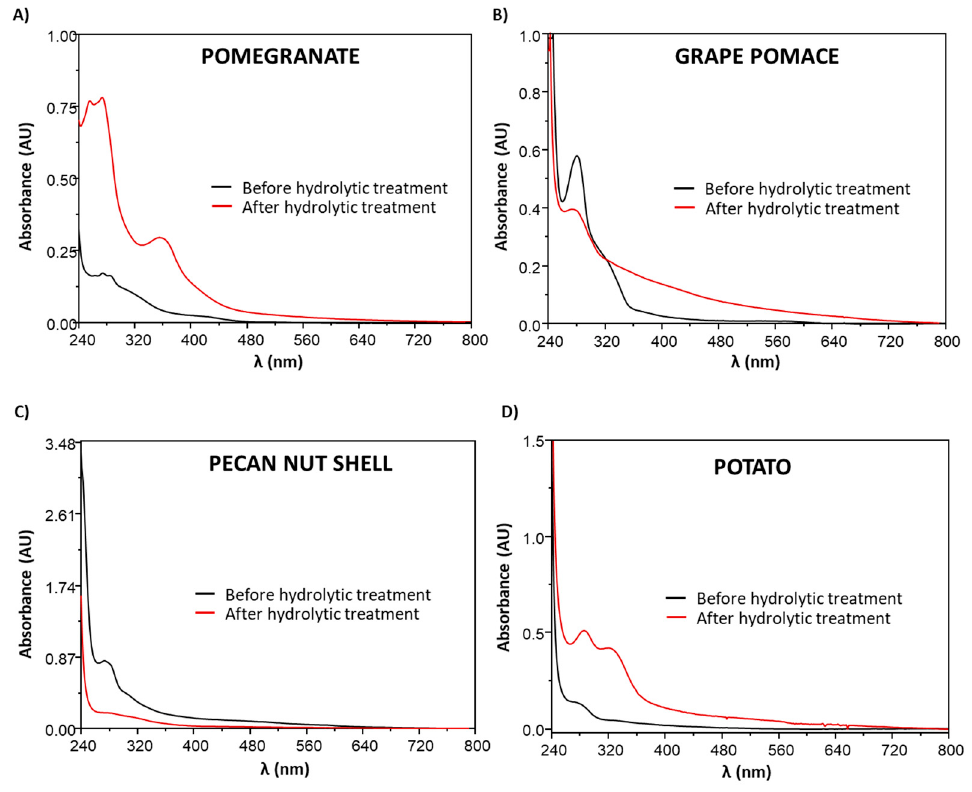
Figure 10. UV-Vis spectra of the DMSO extractable fraction of ( A ) pomegranate waste (0.02 mg / mL), ( B ) grape pomace (0.2 mg / mL), ( C ) pecan nut shell (0.2 mg / mL) and ( D ) potato waste (0.2 mg / mL) before and after the hydrolytic treatment. Concentrations refer to the starting dose of each agri-food waste in DMSO after proper dilution in methanol (see paragraph 2.11).